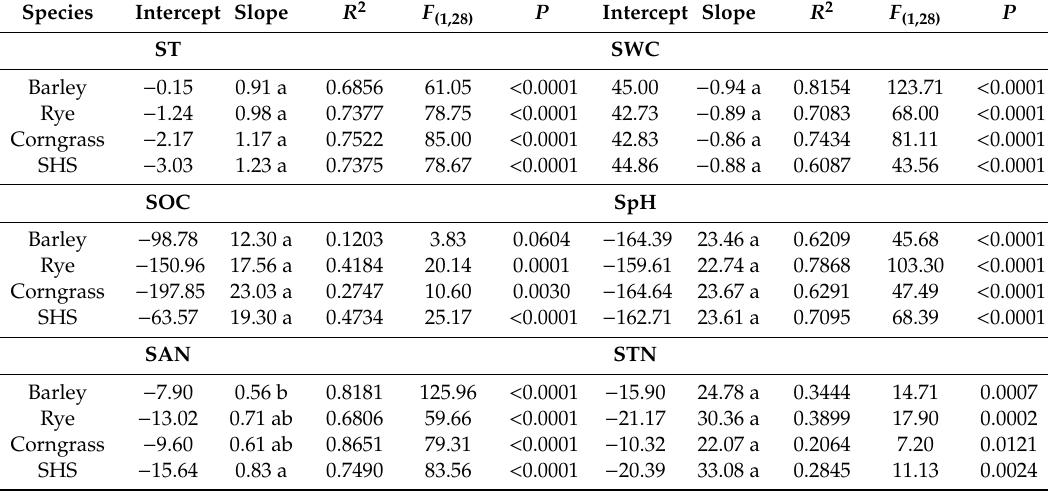
Table 2. Summary of linear regressions (Figure 3) between soil N 2 O fluxes and soil properties: soil temperature (ST), soil water content (SWC), soil organic carbon (SOC), soil pH (SpH), soil available nitrogen (SAT), and soil total nitrogen (STN) in barley, rye, corngrass, and SHS fields. For each soil property, slopes with the same letters are not significantly di ff erent between species ( P >